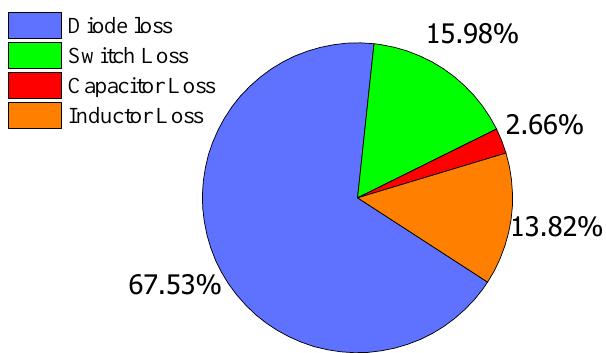
Figure 19. Total power loss distribution at the duty cycle of 0.15.